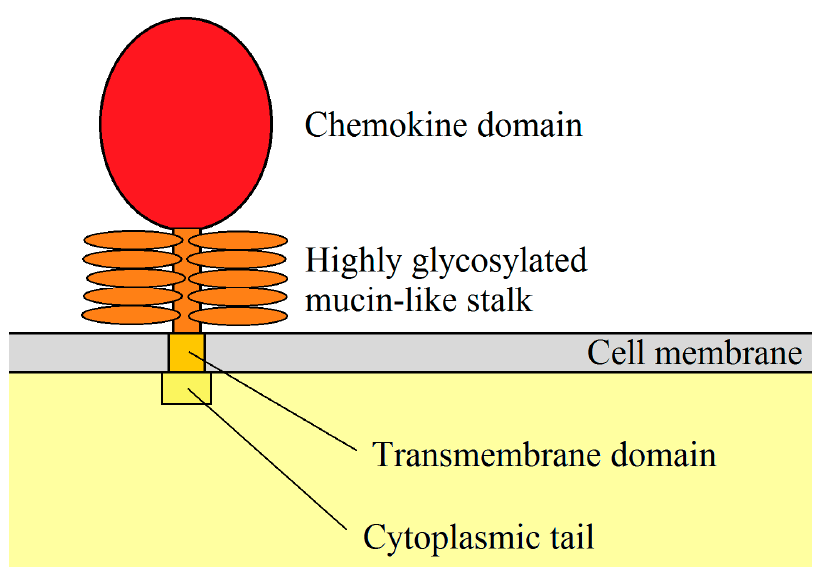
Figure 1. mCXCL16 structure. CXC motif chemokine ligand 16 (CXCL16) is a membrane protein consisting of a chemokine domain, highly glycosylated mucin-like stalk, transmembrane domain and cytoplasmic tail.